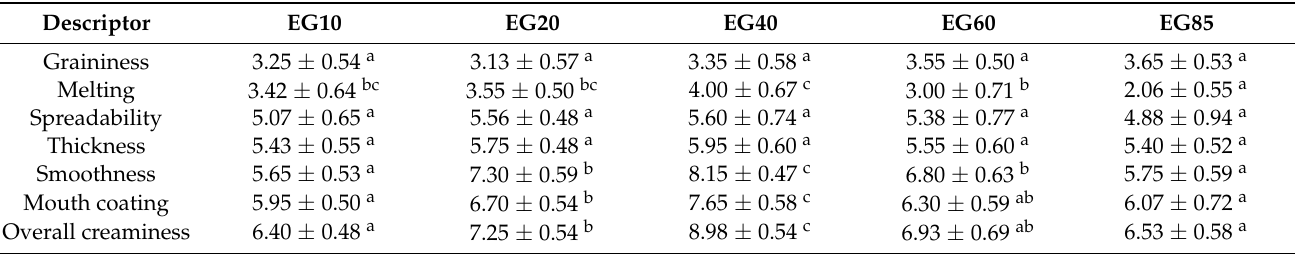
Table 4. Quantitative descriptive analysis evaluation scores of acid milk gels with different solid